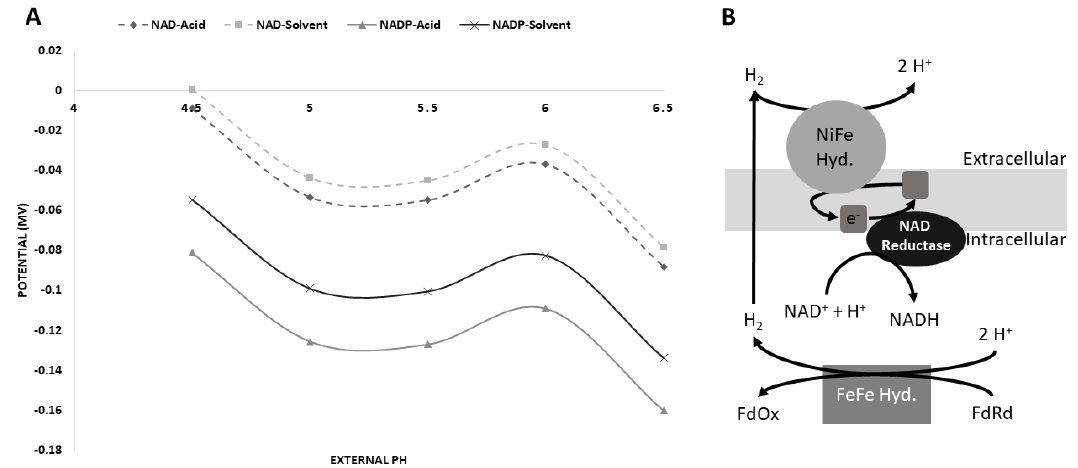
Figure 5. Possible physiological role of [NiFe-hydrogenase]. Panel ( A ) indicates NAD + and NADP + reduction potentials calculated for the [NiFe]-hydrogenase schematic in panel B for acidogensis and solventogensis. Details of the calculations are available in the material and methods and supplemental material; Panel ( B ) is a schematic of potential hydrogen cycling with the [FeFe]-hydrogenase and [NiFe]-hydrogenase. Protons are reduced to H 2 intracellularly by the [FeFe]-hydrogenase and the H 2 can freely cross the membrane. The [NiFe]-hydrogenase is localized on the extracellular membrane face, converting H 2 to protons externally. Electrons are transported via an electron transport molecule to a cytoplasmic-facing NAD + reductase.